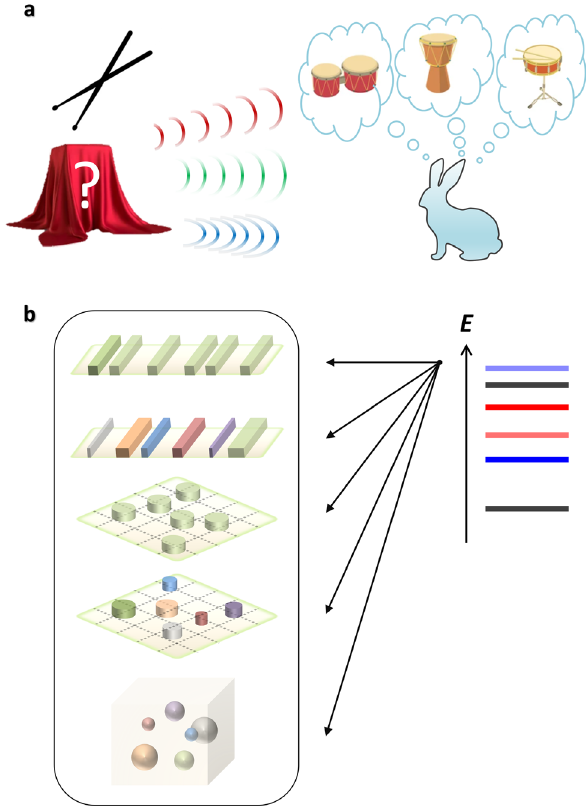
Figure 1: Concept of isospectrality. (a) Can this rabbit describe the shape of a drum behind a veil by hearing only its sound spectrum? It is impossible because there can exist different shapes of drums that provide the same sound spectrum. Such a family of drums satisfies “ isospectrality ” . Image credits: a veiled drum (Viktoriya_Y/Shutterstock.com), drum sticks (martialred/Shutterstock.com), drums (ViktoriaKazakova/ Shutterstock.com). (b) In wave mechanics, we can also expect a family of materials or structures having different compositions or dimensionalities, which provide the same (real or complex) eigenspectrum E